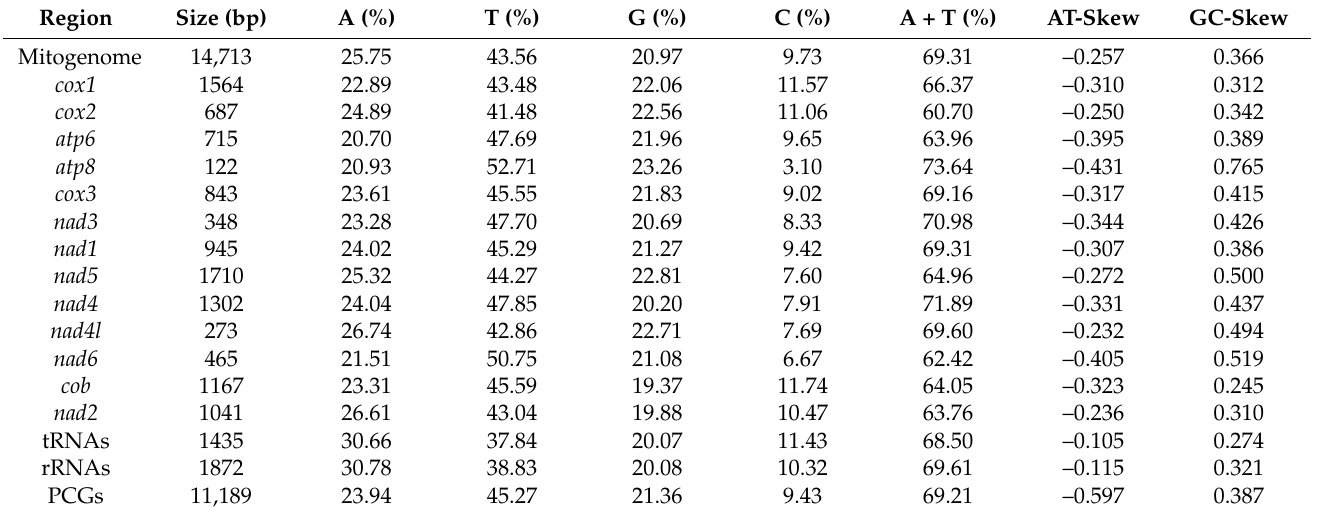
Table 1. Skewness of the M. virgata mitogenome.